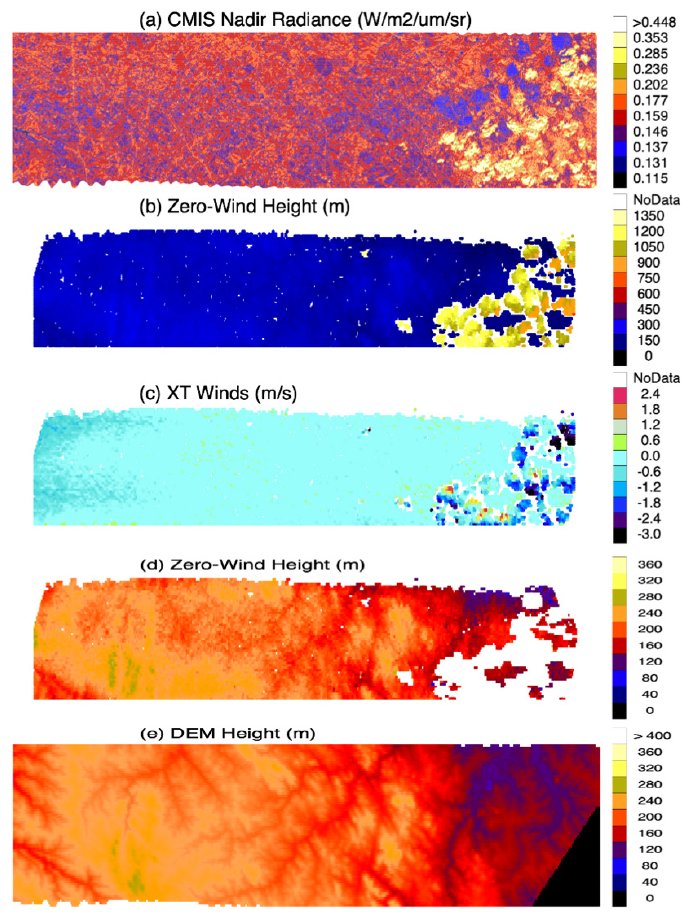
Figure 9. Analysis of hold F2 on 27 Jan 2021 for ( a ) CMIS calibrated radiance; ( b ) CMIS zero-wind stereo height; ( c ) CMIS XT winds; ( d ) zero-wind heights with color contouring to highlight surface elevation differences; and ( e ) surface height from a digital elevation model (DEM). The direction of flight is from left to right, which is toward the northwest near Durham, NC, USA.